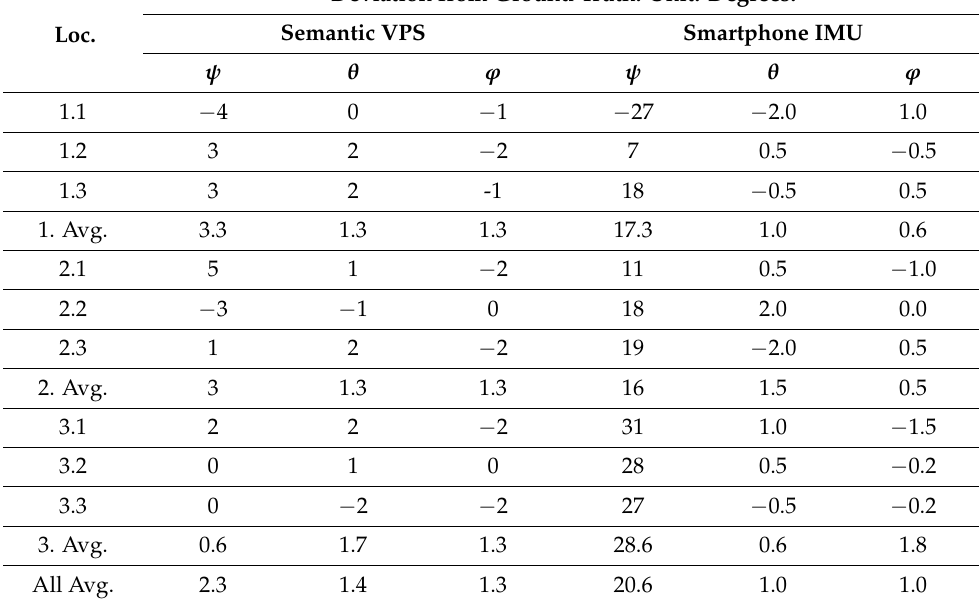
Table 6. Heatmap of the likelihood of candidate images compared to the smartphone image based on the proposed semantic VPS method. Deviation from Ground Truth. Unit: Loc.